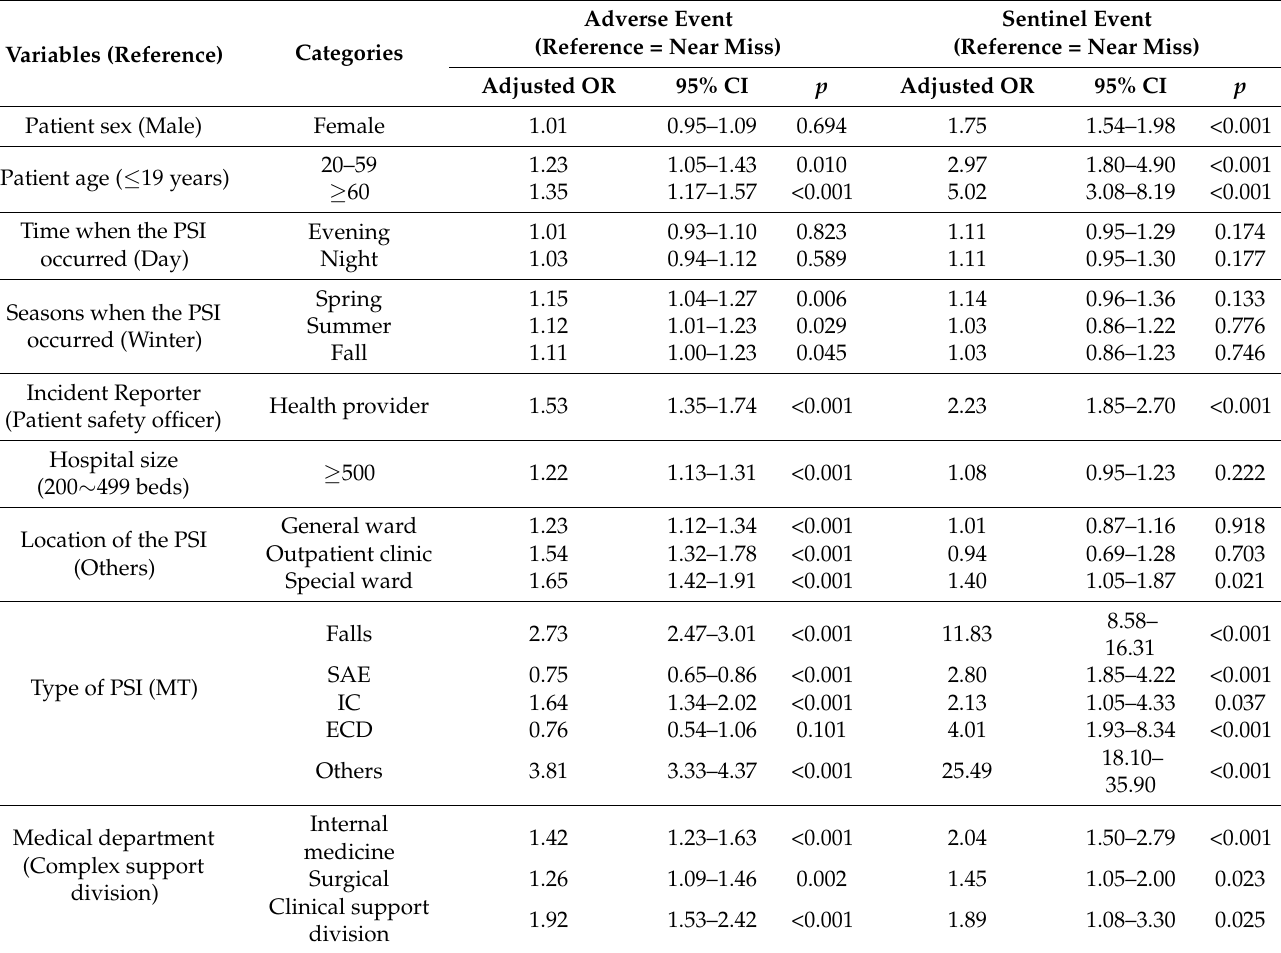
Table 2. Multinomial logistic regression analysis for predicting PSIs ( N =